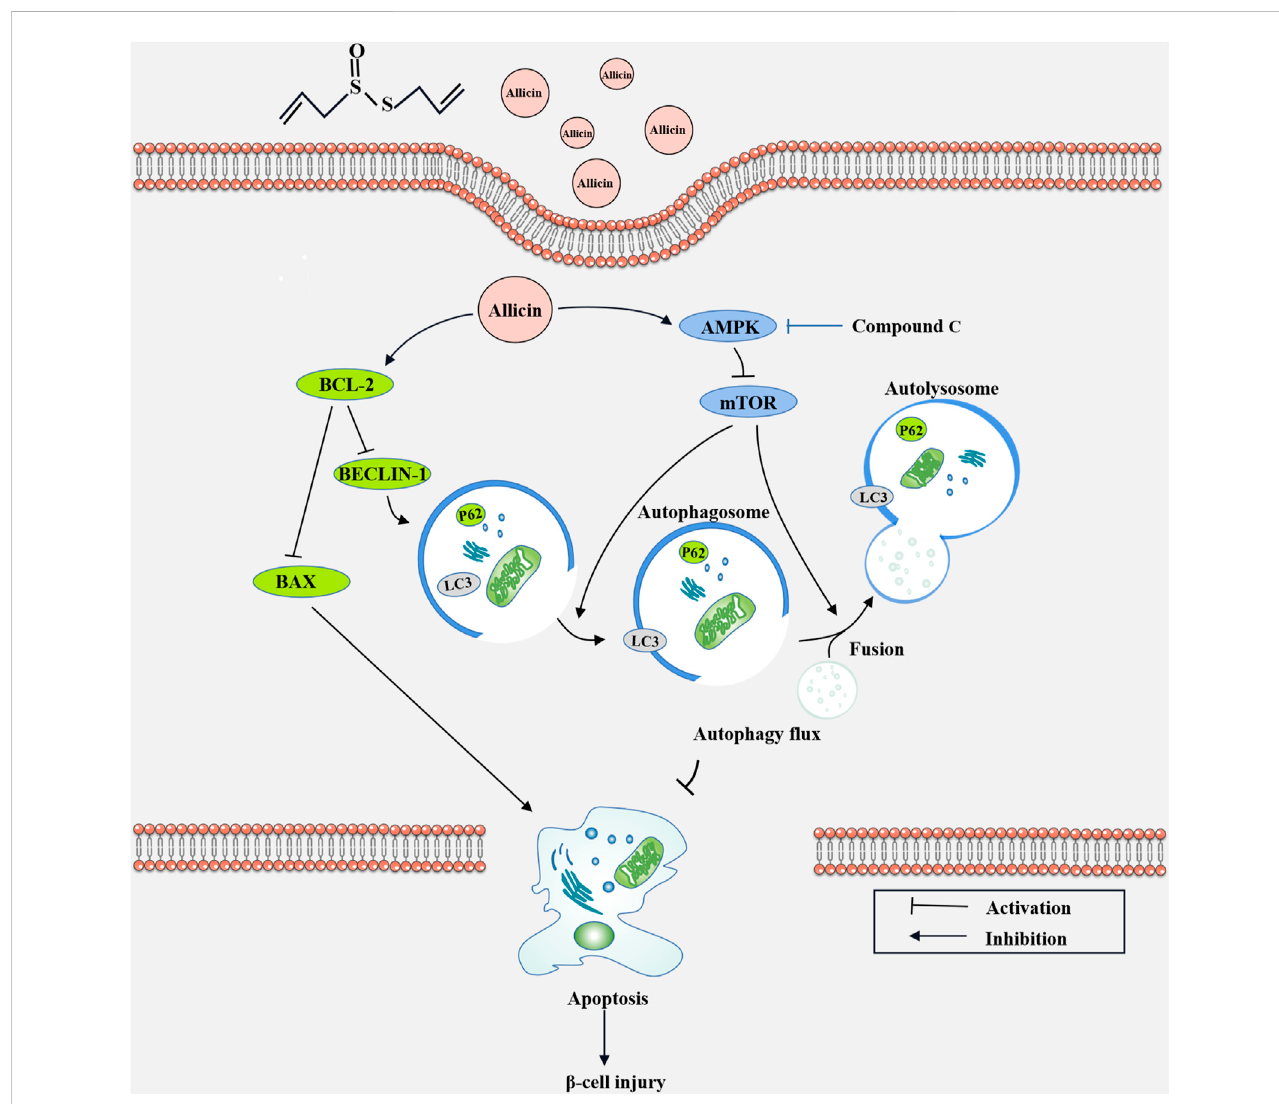
FIGURE 8 The diagram of the underlying mechanism for Allicin protection roles in T1DM through AMPK/mTOR mediated autophagy